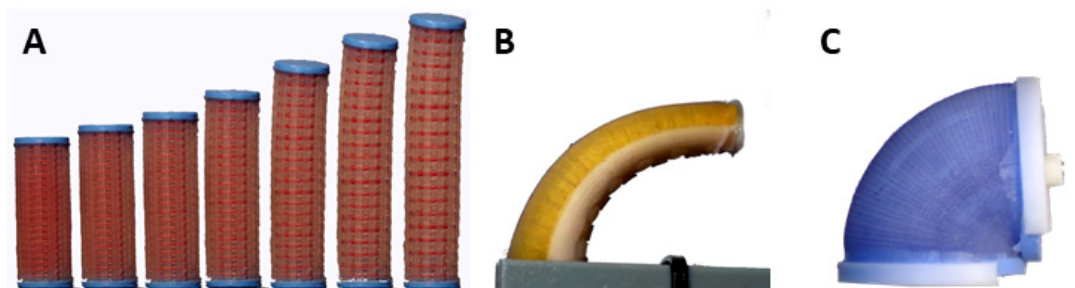
Figure 4. Primary motions in soft robotics. ( A ) Soft linear actuator elongating due to increasing pressure being supplied [33]; ( B ) Soft robot segment bending due to strain-limiting material being used on one side of the actuator [30]; ( C ) Soft robot segment rotating due to its toroidal geometry [31].